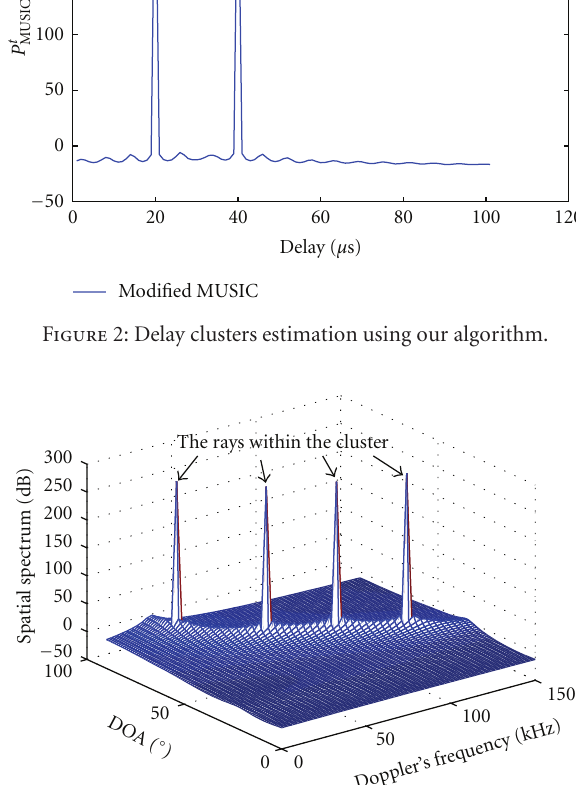
Figure 3: Joint DOA and Doppler’s frequency estimation of first cluster using our